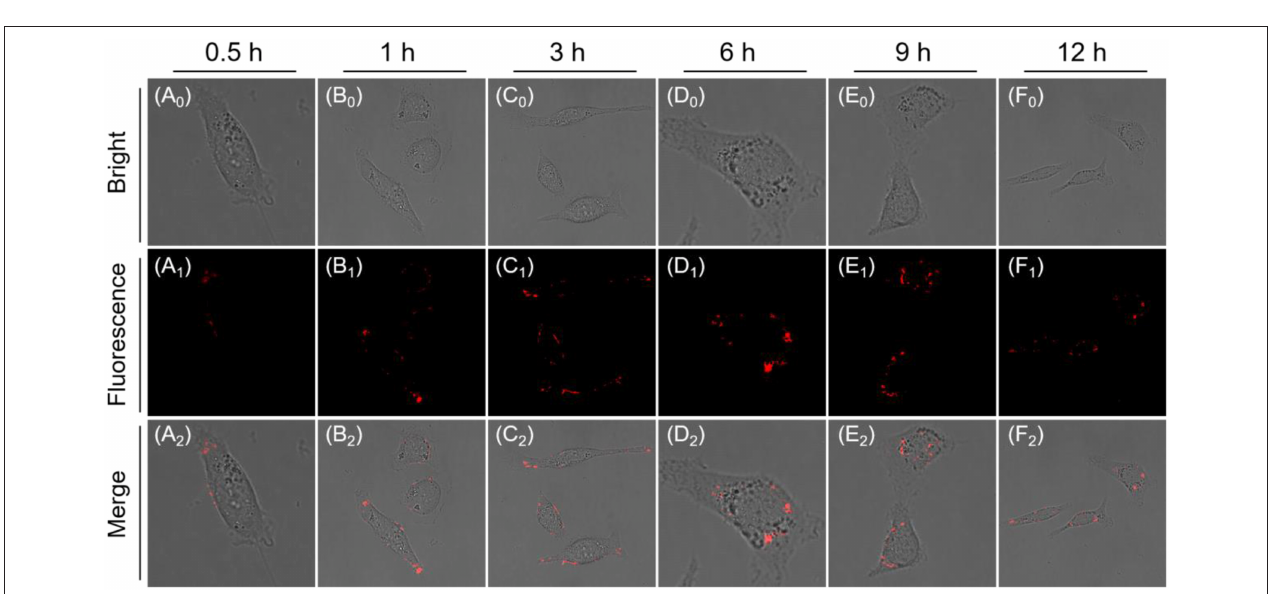
FIGURE 5 | Time-dependent CLSM images of SKOV-3 cells incubated with QM-HBT- β gal (10 µ M) ( A 0 -F 0 : Bright field, A 1 -F 1 : Fluorescence channel) and ( A 2 -F 2 : Merge channel). The window of fluorescence emission collection is 650–700nm ( λ ex = 460nm).